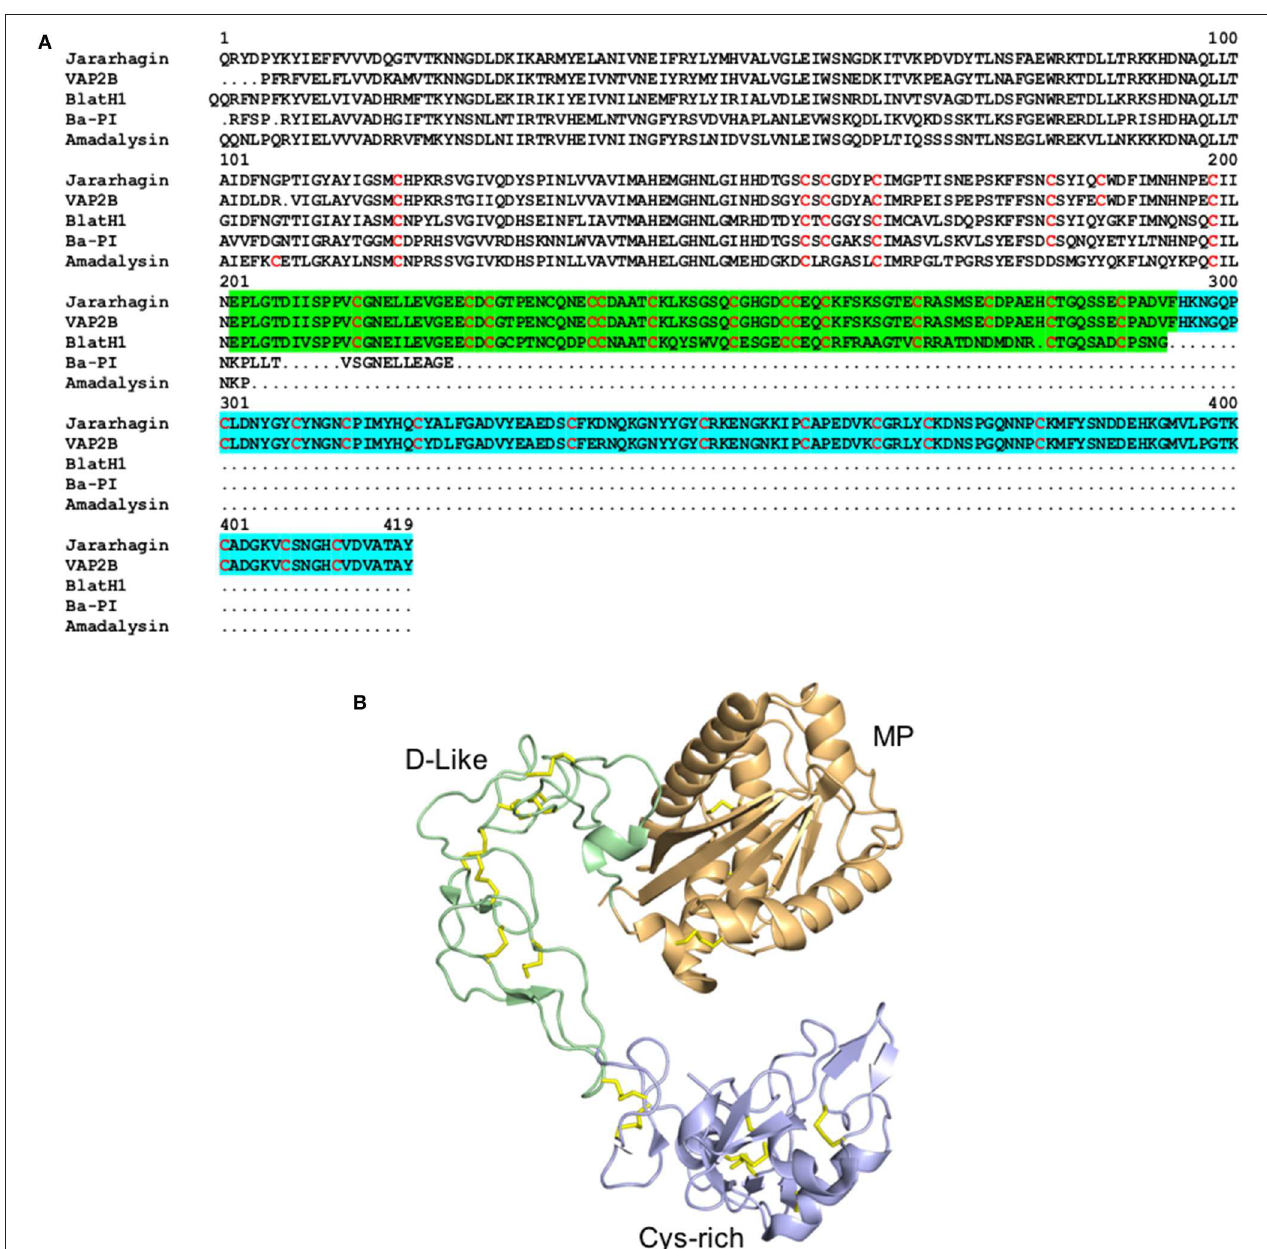
FIGURE 2 | Structure of metalloproteinaises from snake venoms. (A) Alignment of the primary structure of the SVMPs Jararhagin from Bothrops jararaca (Uniprot P30431) and VAPB2 from Crotalus atrox (Uniprot Q90282) belonging to the class P-III, BlatH1 from Bothriechis lateralis (Uniprot U5PZ28) belonging to the class P-II, and Ba-PI from Bothrops asper (Uniprot P83512) and Adamalysin from Crotalus adamanteus (Uniprot P34179) belonging to classes P-I. Cysteines are colored in red, the disintegrin-like domain is highlighted in green and the cysteine-rich domain is highlighted in blue. (B) Cartoon representation of the three-dimensional structure of the class P-III metalloproteinase VAPB2 from Crotalus atrox (PDB 2DW0). The metalloproteinase domain is colored in orange, the disintegrin-like domain (D-like) is colored in green and the cysteine-rich domain (Cys-rich) is colored in blue. The disulphide bridges are colored in yellow.